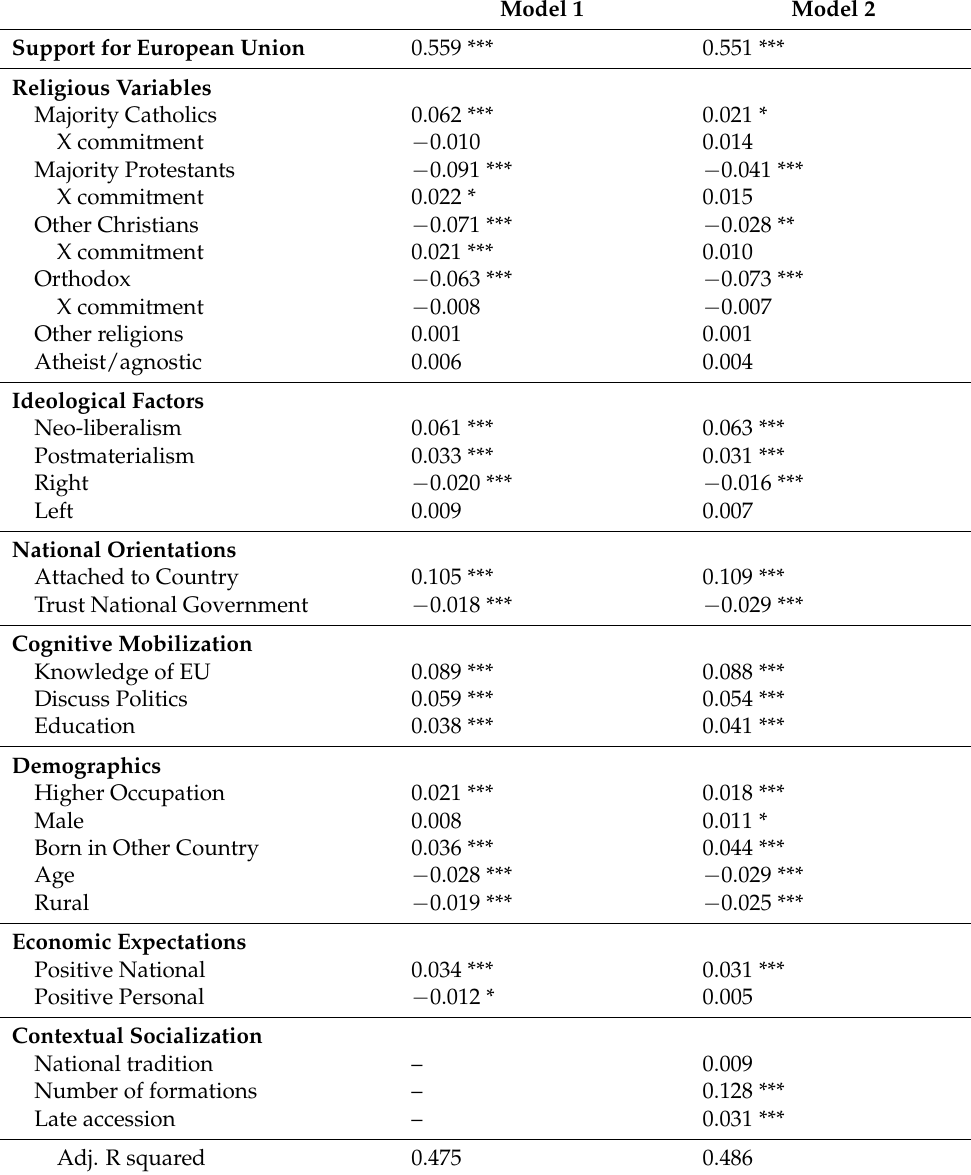
Table 4. European Identity, Individual Traits and National Context (OLS regression betas